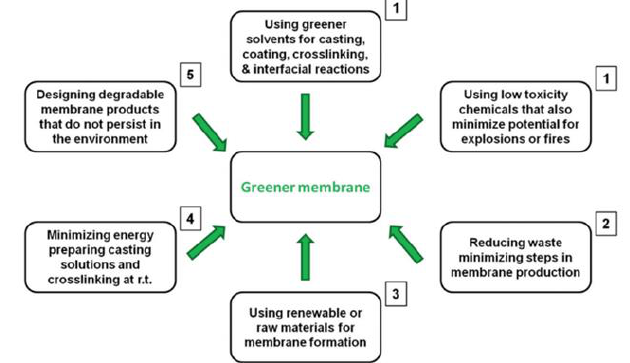
Figure 2. Bioplastic films obtained from vegetable wastes in mild aqueous conditions: ( A ) carrot bioplastic; ( B ) parsley bioplasgtic; ( C ); radicchio bioplastic; ( D ) cauliflower bioplastic. (Reprinted with permission from Ref. [89]. Copyright 2018 Royal Society of Chemistry.)